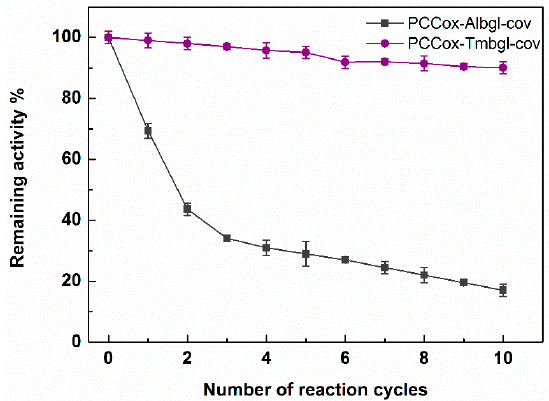
Figure 9. Reusability of covalently immobilized β -glucosidases on PCCox in citrate phosphate buffer 100 mM pH 5.0 and pH 6.5 for Albgl and Tmbgl, respectively, at 37 °C when the enzyme is covalently immobilized on PCCox.